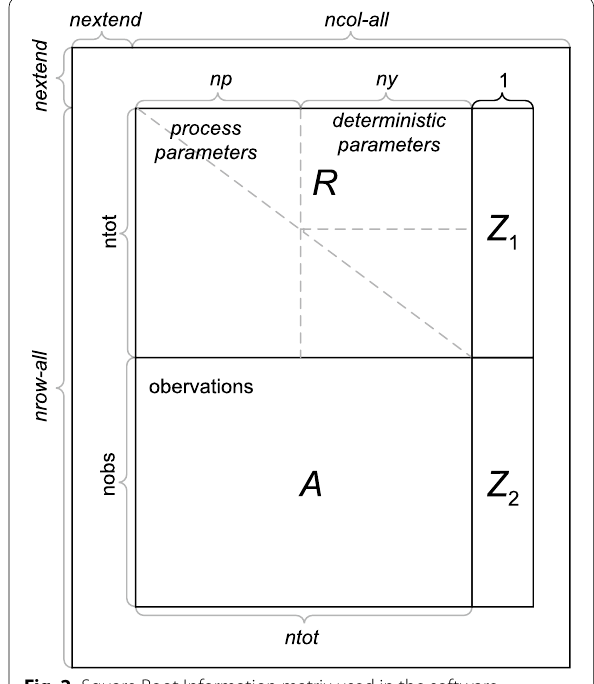
Fig. 2 Square Root Information matrix used in the software implementation and the information storage related to the